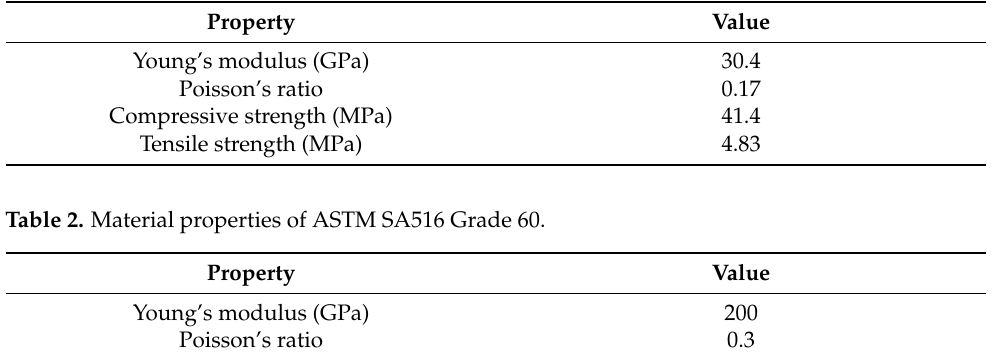
Table 1. Material properties of concrete.